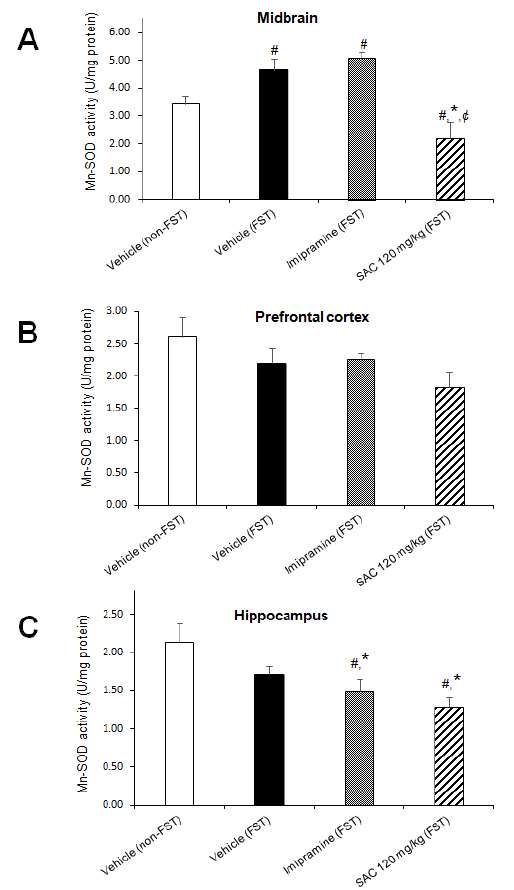
Figure 6. The antidepressant-like behavior exhibited by SAC (120 mg/kg) in the FST is related with downregulation of Mn-SOD activity in midbrain and hippocampus. The vehicle (non-FST or FST), imipramine (FST) or SAC (120 mg/kg) were the treatment groups. Mn-SOD was analyzed in the midbrain ( A ), prefrontal cortex ( B ), and hippocampus ( C ). Results are expressed as mean ± SEM of 6–8 animals per group. The one-way ANOVA followed by post hoc Duncan’s tests was used to analyze the differences among groups. (#) Statistically different from the non-FST group, p < 0.05, Duncan’s test; (*) statistically different from the vehicle-FST group, p < 0.05, Duncan’s test; (¢) statistically different from the imipramine-FST group, p < 0.05, Duncan’ test. Mn -SOD = manganese-superoxide dismutase; FST = forced swimming test; SAC = S-allyl cysteine.